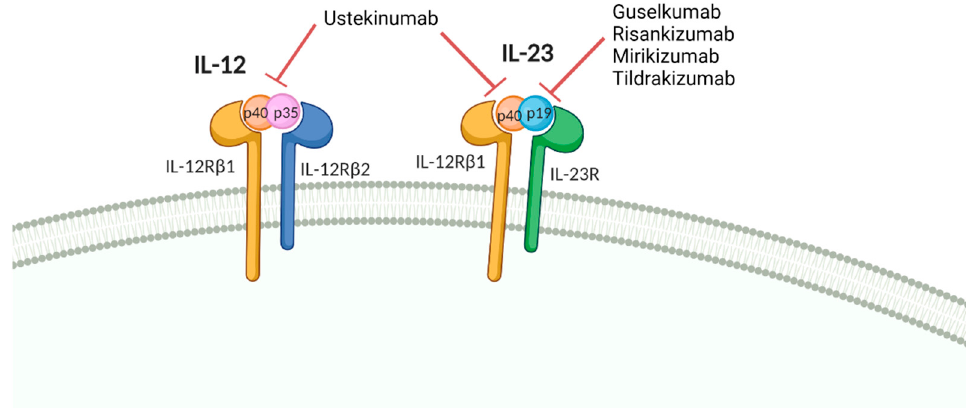
Figure 1. Schematic representation of IL-12 and IL-23 cytokines and its receptors. Figure created with Biorender.com [141].